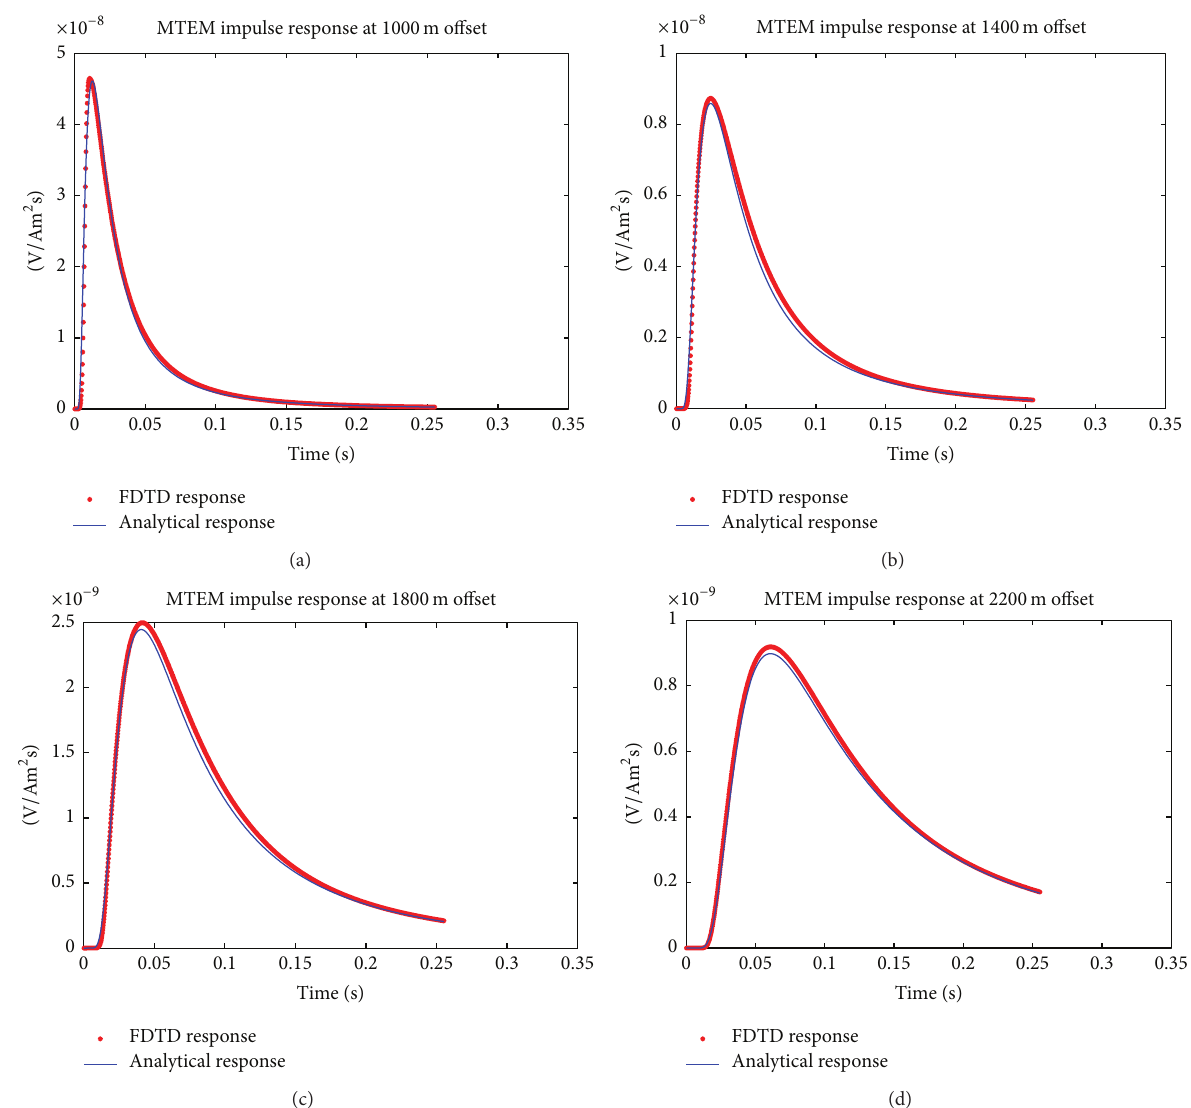
Figure 6: MTEM earth impulse responses at offsets: (a) 1000m; (b) 1400 m; (c) 1800 m; and (d) 2200 m.